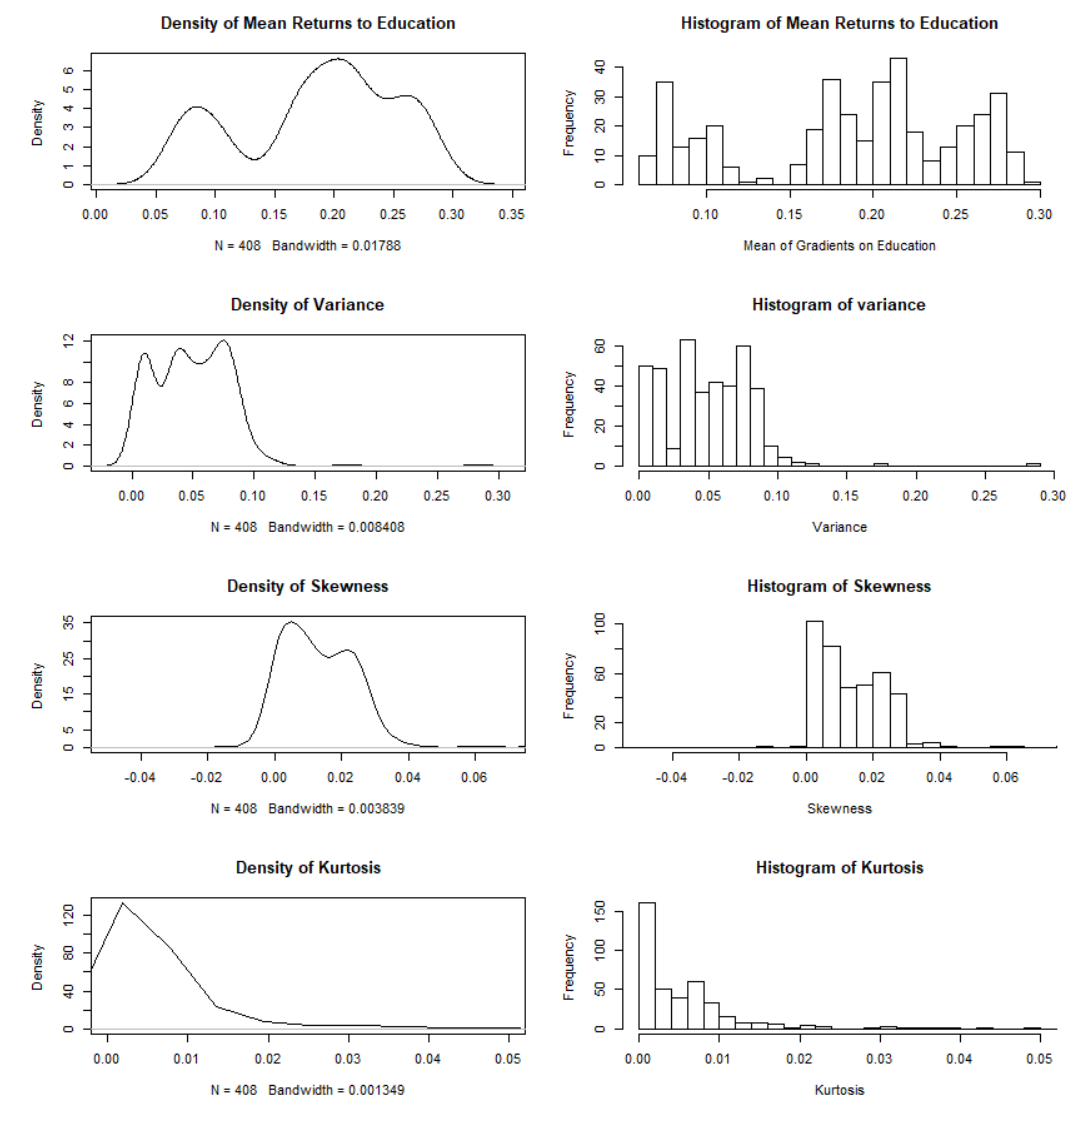
Figure 3. Moments